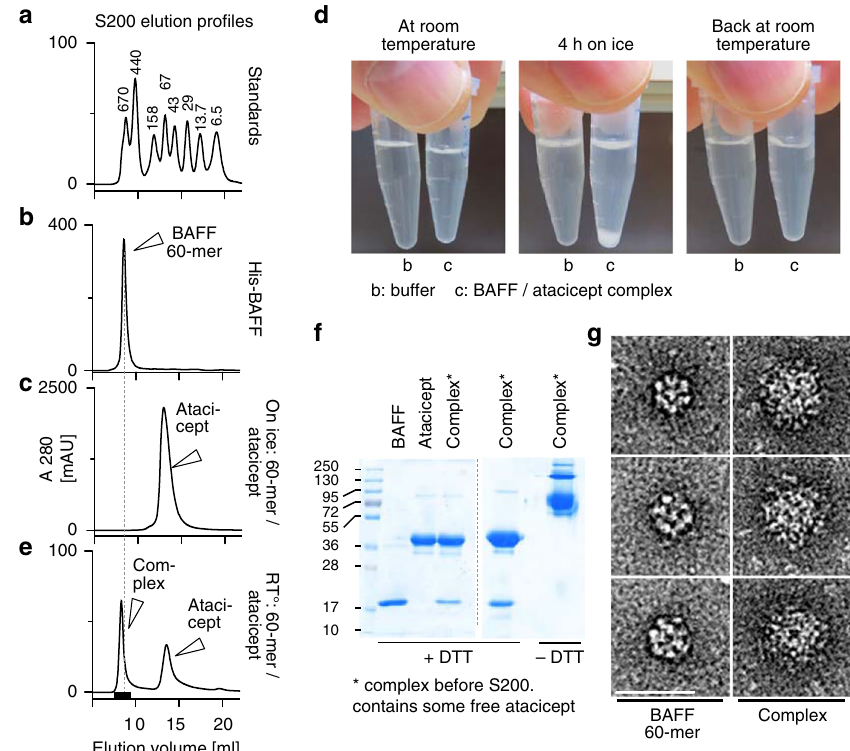
Fig. 9 Binding of atacicept to BAFF 60-mer does not induce BAFF dissociation. BAFF 60-mer was mixed with an excess of atacicept to form a complex that